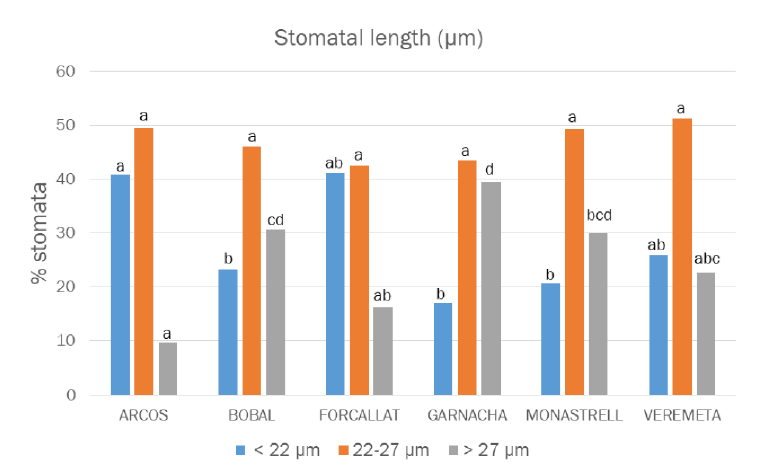
Figure 3. Stomata frequency (%) with lengths < 22µm, between 22 – 27 µm, and >27 µm in leaves from grapevine varieties. Mean values within a column separated by different lowercase letters are different ( p < 0.05).